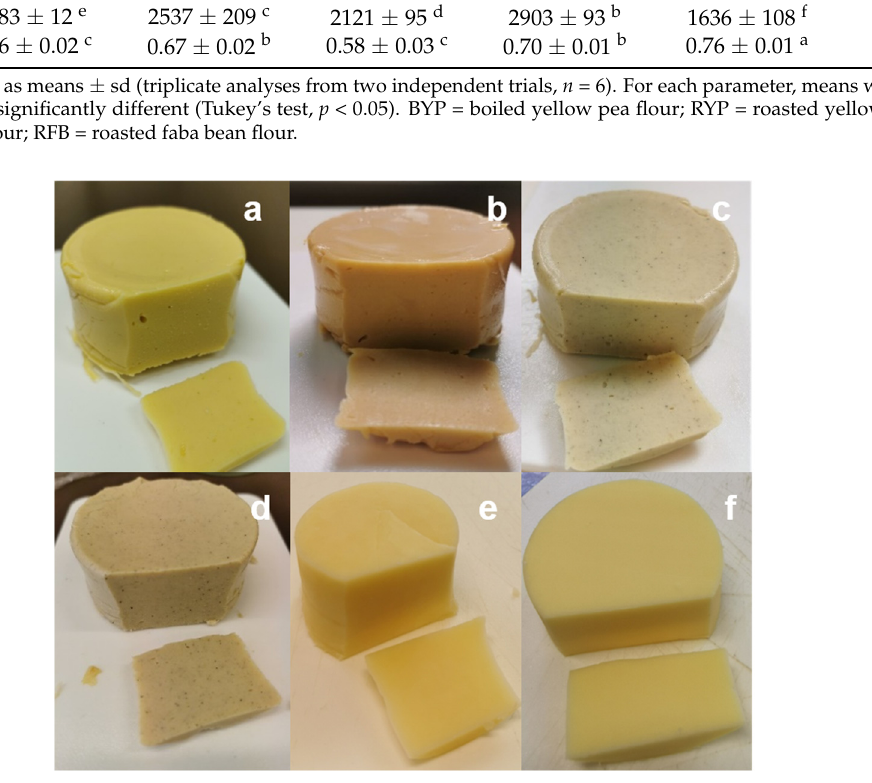
Figure 2. Pulse-based cheese analogues: BYP ( a ); RYP ( b ); BFB ( c ); RFB ( d ); reference samples Gouda cheese ( e ); vegan cheese analogue ( f ). BYP = boiled yellow pea flour; RYP = roasted yellow pea flour; BFB = boiled faba bean flour; RFB = roasted faba bean flour. Table 5. Color and texture properties 1 of pulse-based cheese analogues made from different types of pulse flour and the reference products.